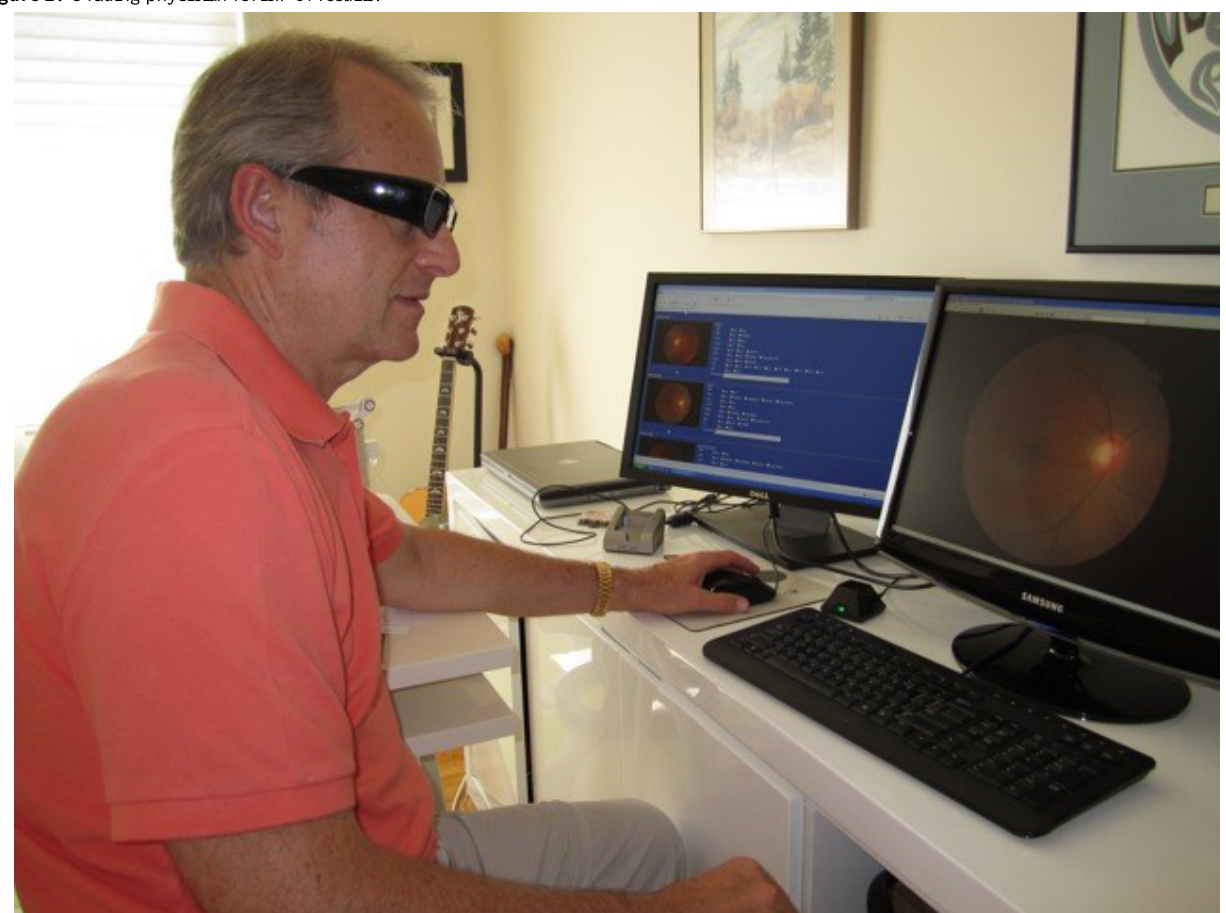
Figure 2. Grading physician review of